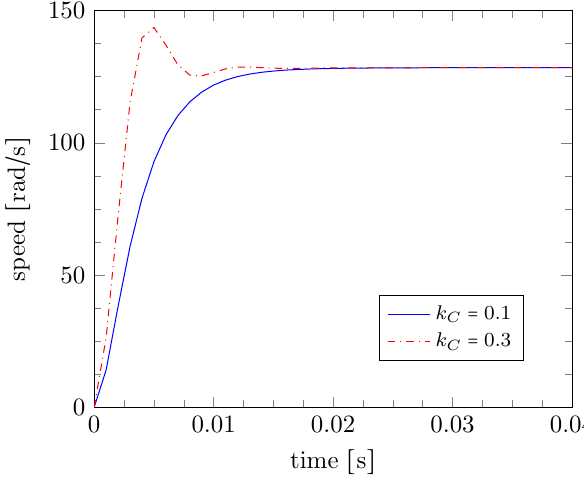
Figure 10: Step response of SIL model (with DCPM engine model and actuator saturation) for different controller gain values k C .